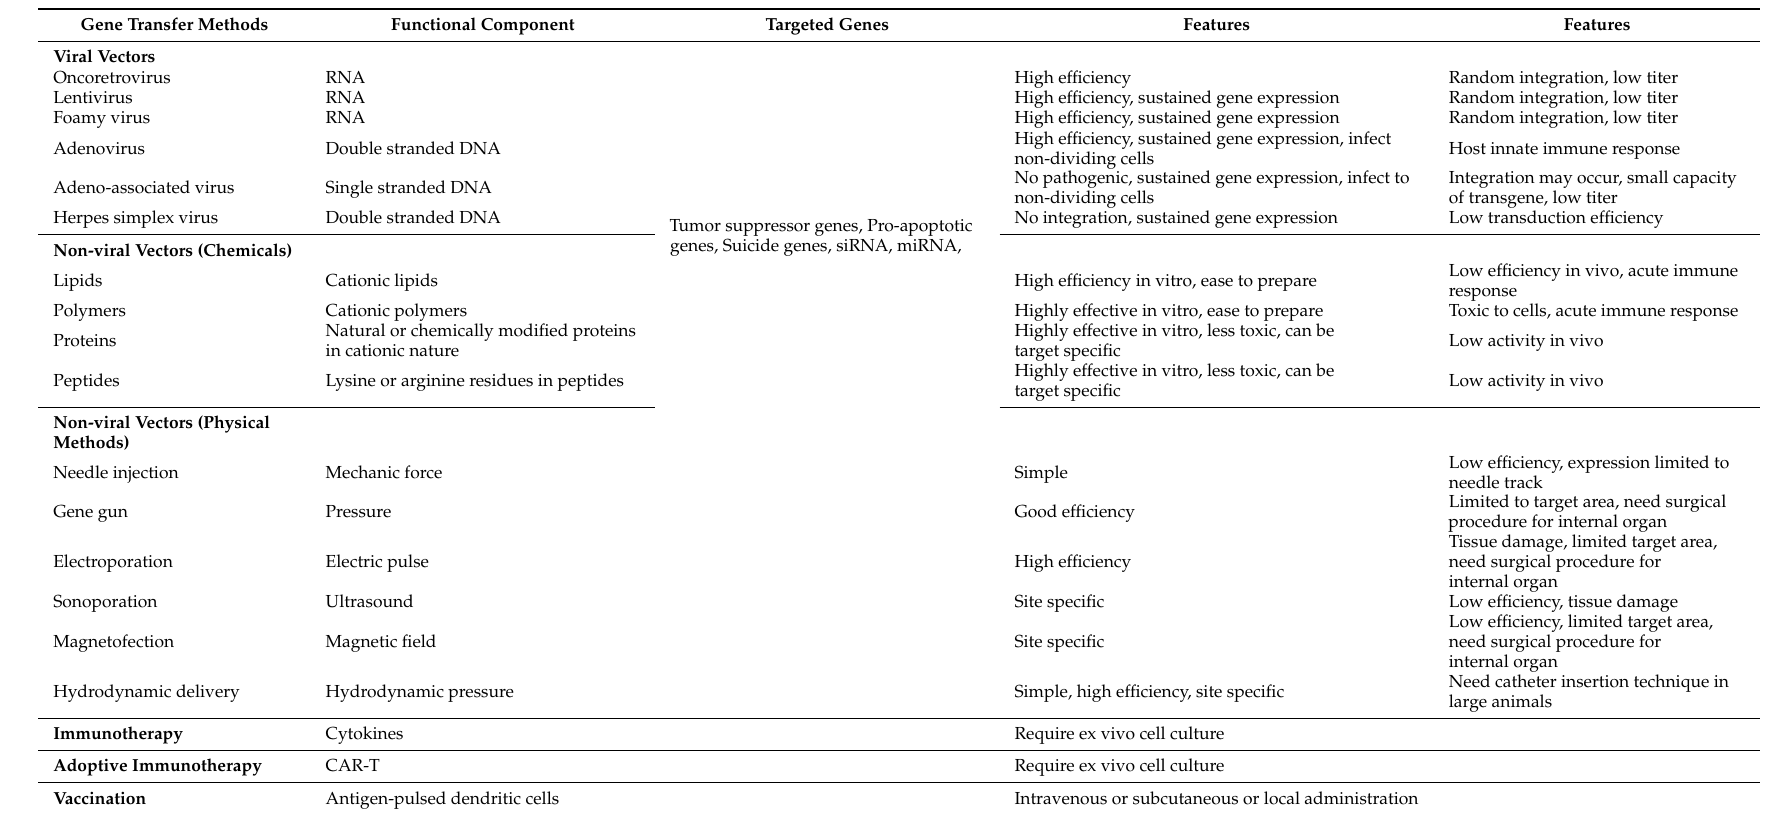
Table 3. Gene delivery methods used in clinical and pre-clinical